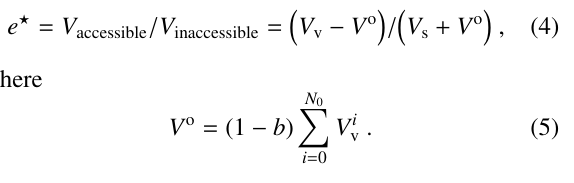
– III of the mechanical